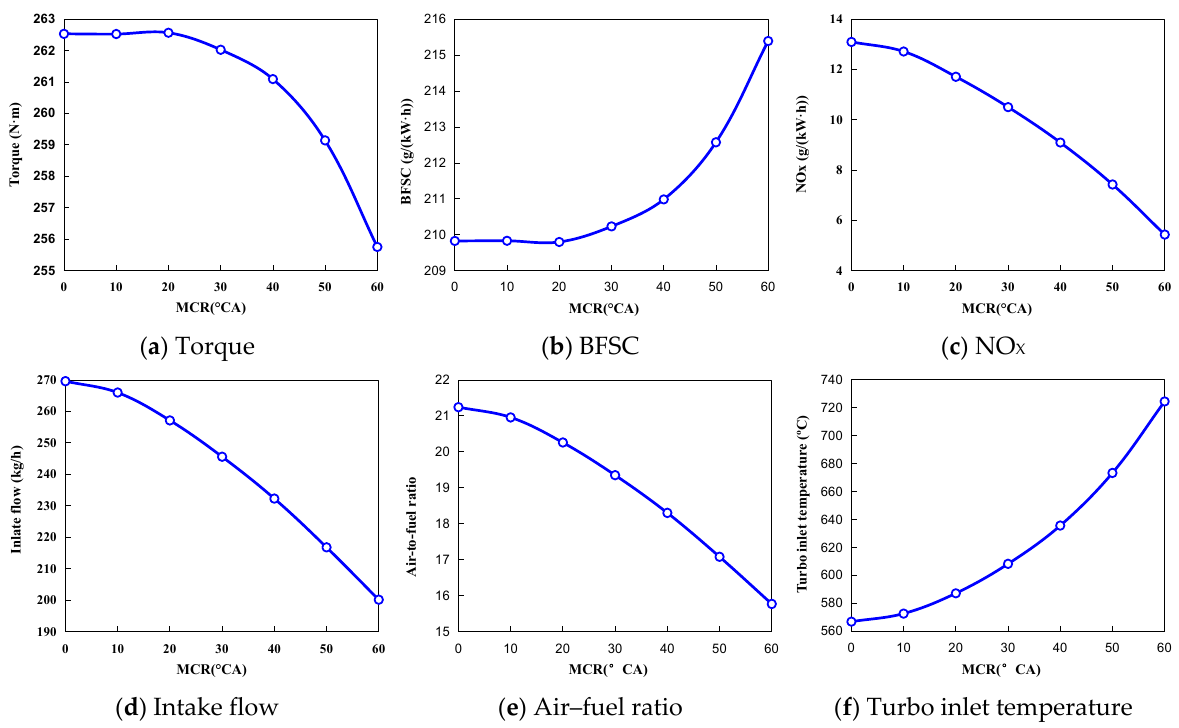
Figure 7. Effects of the MCR on the performance and emission of a diesel engine.